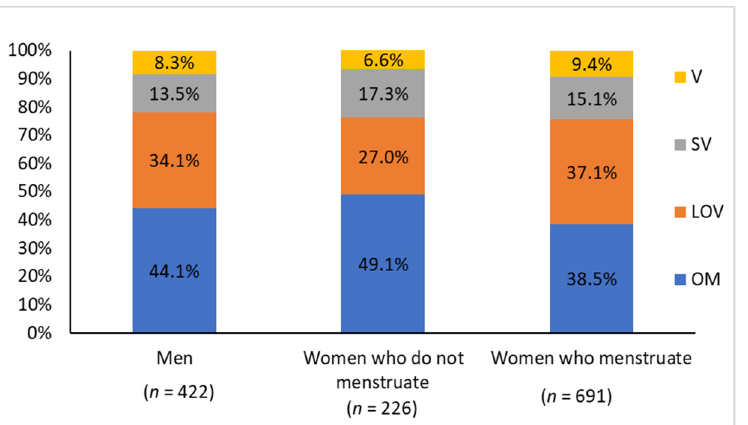
Figure 1. Sample distribution in relation to eating habits for each group: OM (omnivore), LOV (lacto-ovo vegetarian), SV (semi-vegetarian), and V (vegan). Comparison of the distribution of eating habits between groups: men vs. women who do not menstruate ( p = 0.1645); men vs. women who menstruate ( p = 0.3306); women who do not menstruate vs. women who menstruate ( p = 0.0086). To comparatively evaluate the groups (men, women who do not menstruate, and women who menstruate) regarding BMI, hs-CRP, and HOMA-RI, analysis of